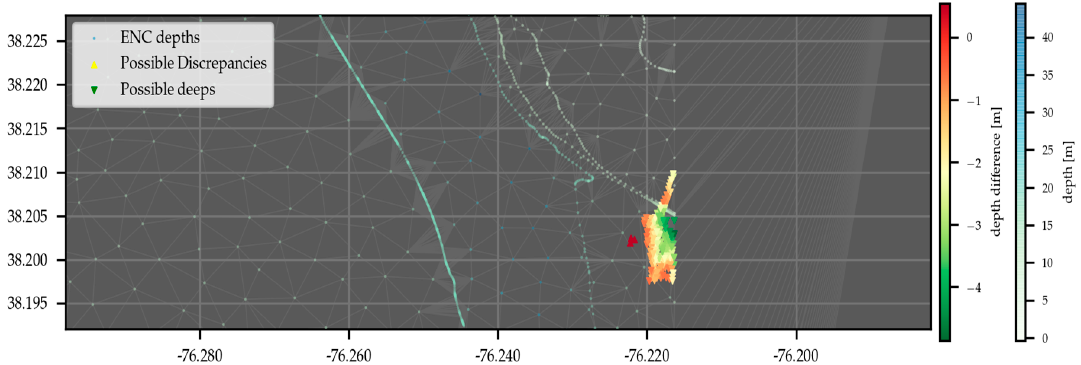
Figure 12. Algorithm results using the eastern part of the H12990 survey soundings compared to the US5VA22M ENC. Axes in geographical WGS84 coordinates.